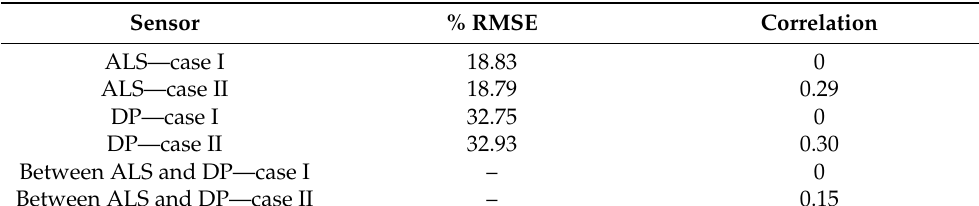
Table 5. Post-calibration relative root mean square errors (%RMSEs) and plot level residual correlations between predictions using the same sensor and across sensors.